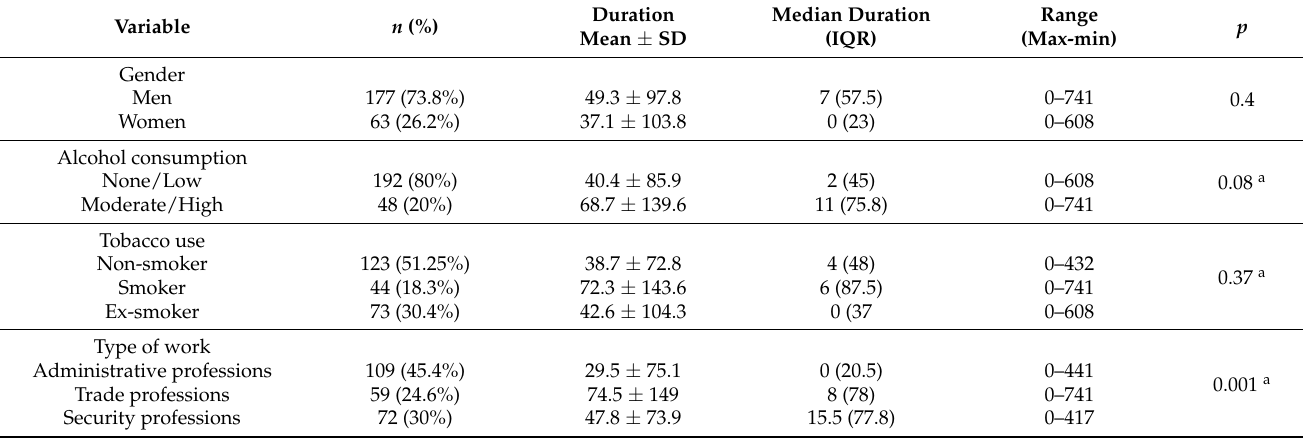
Table 2. Predictor variables and mean duration of common illness/workplace